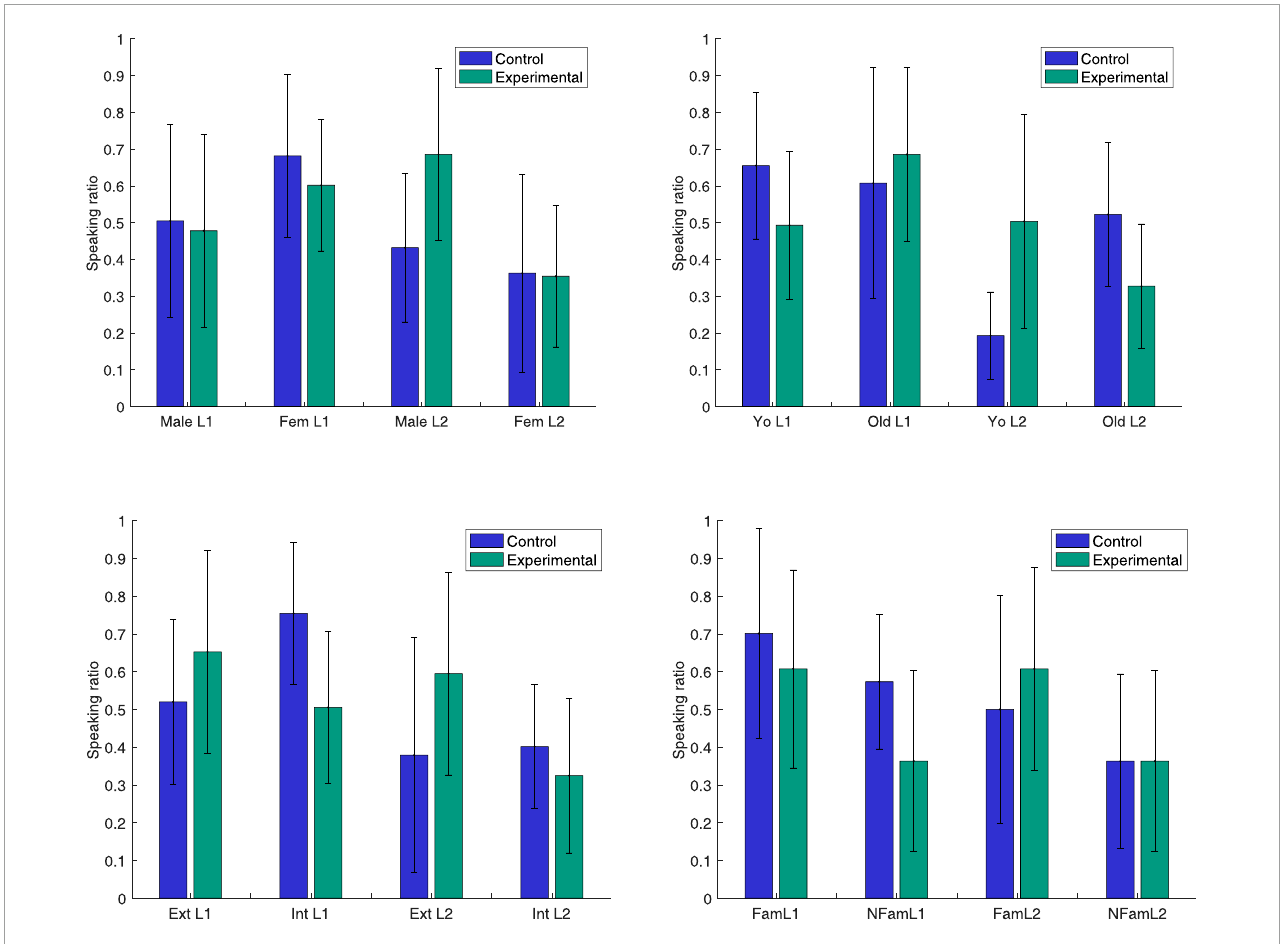
FIGURE 3 Speaking ratios r in Control and Experimental conditions depending on L1 or L2 speaker, in combination with Upper left: male or female (Fem), Upper right: younger (Yo) or older (Old) than the mean age in the group, Lower left: more (Ext) or less (Int) extrovert than the mean level in the group or Lower right: more (Fam) or less (NFam) familiar with robots than the mean level in the